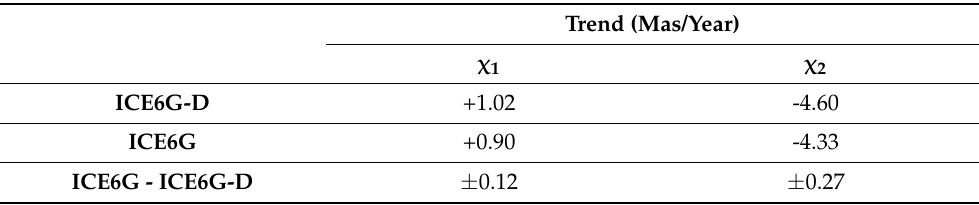
Table 3. Trends in the χ 1 and χ 2 components of HAM/CAM due to GIA signal obtained for ICE6G and ICE6G-D models, and the differences between the